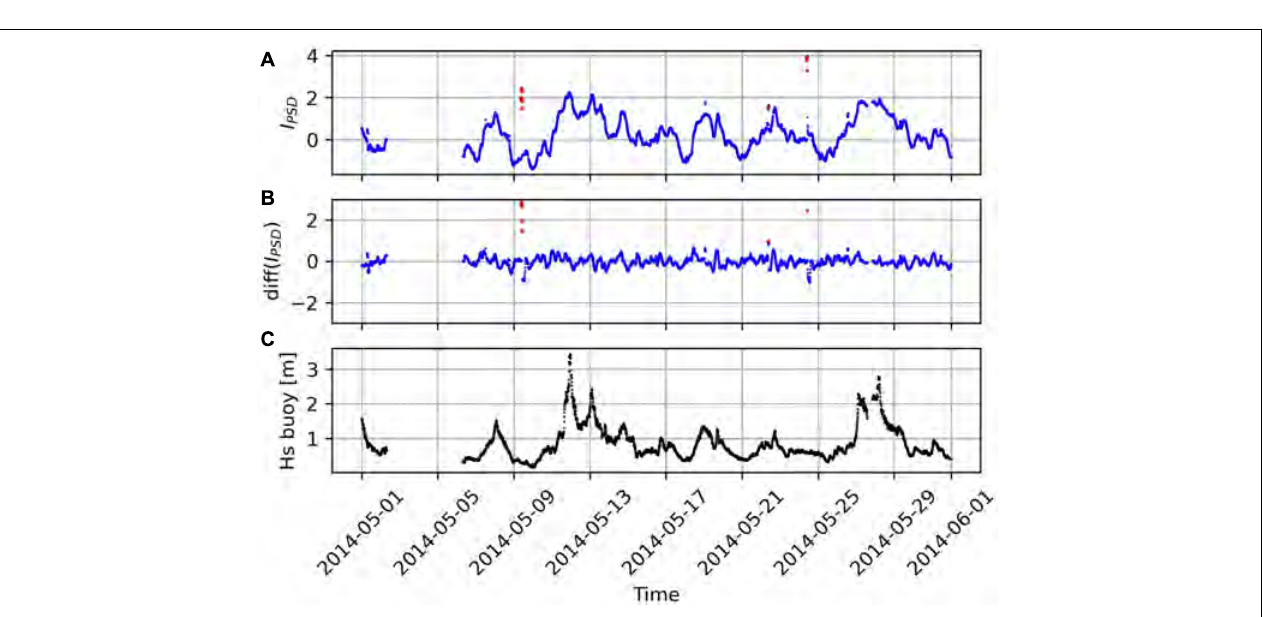
FIGURE 7 | (A) H s observed by the buoy and forecasted with an ARIMA(3,1,5) model. Each forecast is evaluated using the past observed values. The error limits are too small to be visible on this scale. (B) Deviation of the forecasted values from the observed ones.